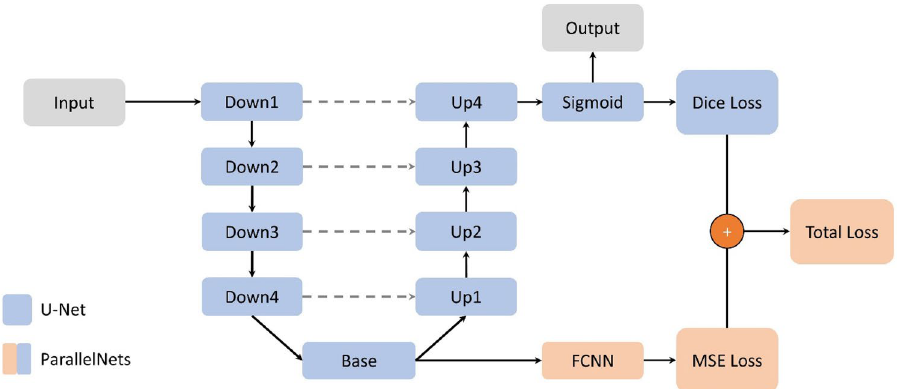
Figure 1. Schematic ParallelNets architecture. The classical U-Net architecture 21 with four encoder blocks (Down) and four decoder blocks (Up) connected by a base block (Base) is shown in blue. Encoder and decoder blocks of the same level are connected by skip connections (gray dashed lines). The additional modules of our ParallelNets architecture are shown in orange and basically consist of a fully connected neural network (FCNN) which is trained to output the crack tip position in terms of normalized x and y